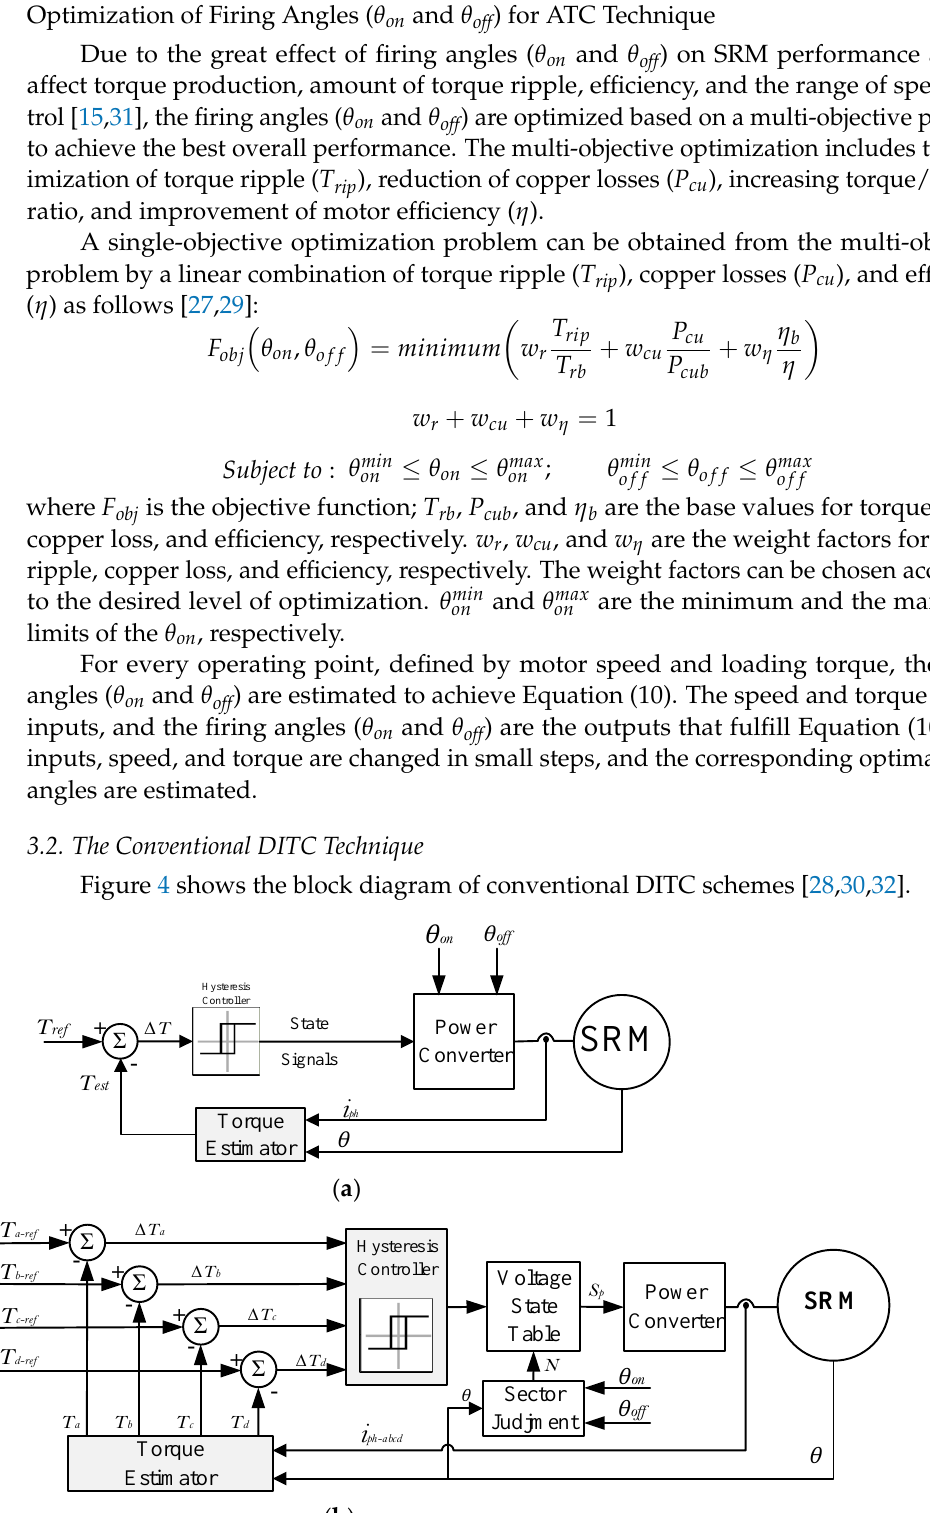
Figure 3. Block diagram of ATC with ( a ) torque controller, and ( b ) torque to current conver- sion.